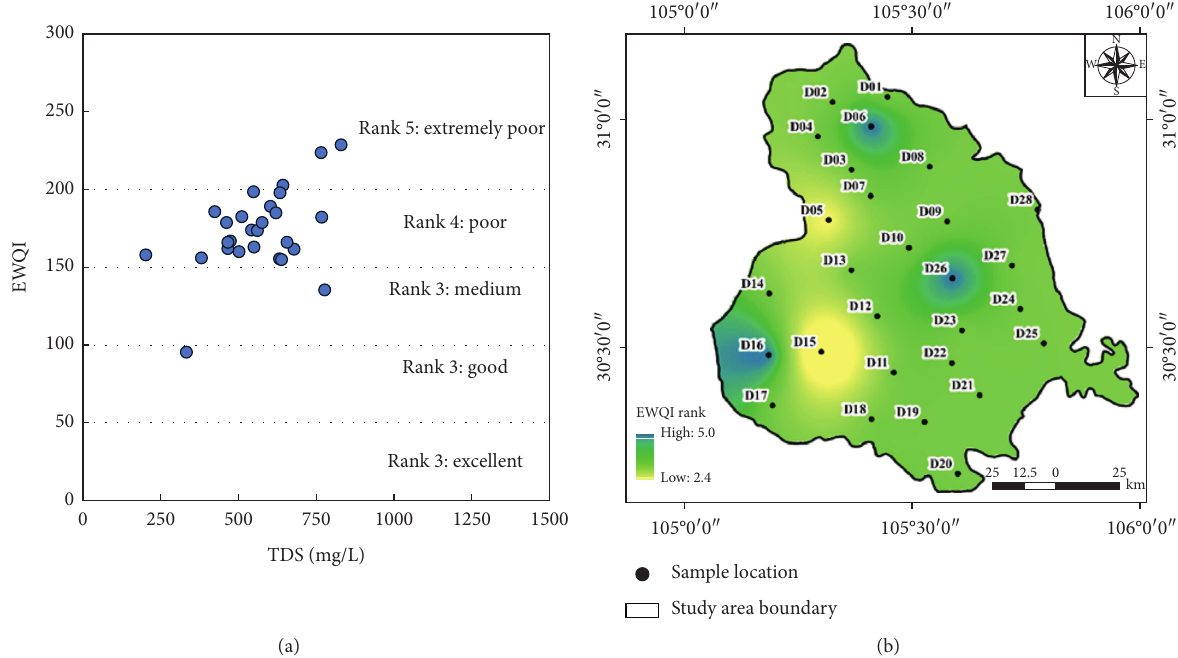
Figure 7: (a) The relationship between the entropy-weighted water quality index (EWQI) and TDS and (b) spatial distribution of groundwater quality based on the EWQI